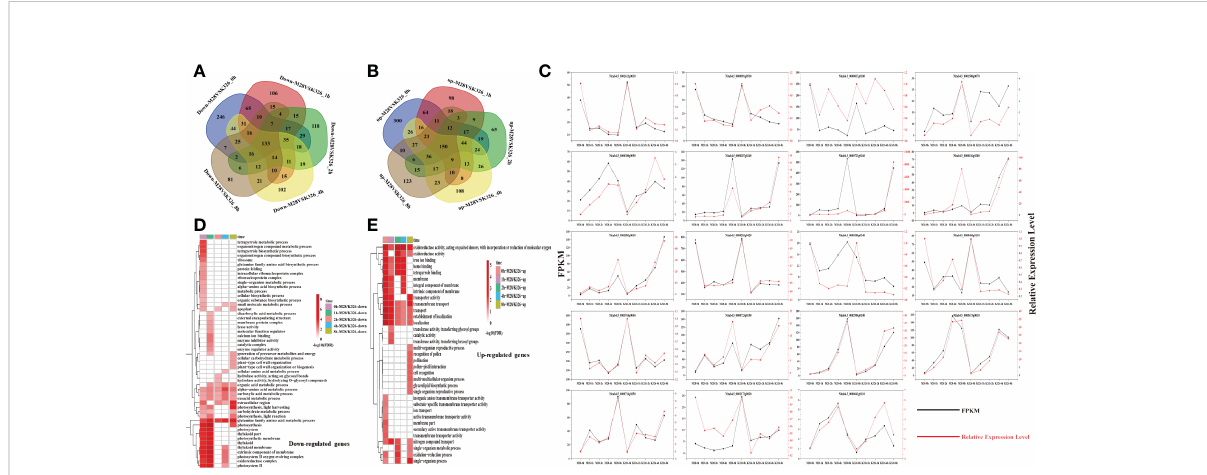
FIGURE 3 Characterization of differentially expressed genes before and after drought treatment in M28 or K326. (A) Pairwise comparisons of down-regulated genes at the same time point between M28 and K326 after drought treatment. (B) Pairwise comparisons of up-regulated genes at the same time point between M28 and K326 after drought treatment. (C) 19 DEGs were randomly selected for RT-qPCR assay. The red line represents the relative expression, and the black line represents the FPKM values. (D) GO term enrichment analyses of down-regulated genes at the same time point between M28 and K326 after drought treatment. (E) GO term enrichment analyses of up-regulated genes at the same time point between M28 and K326 after drought